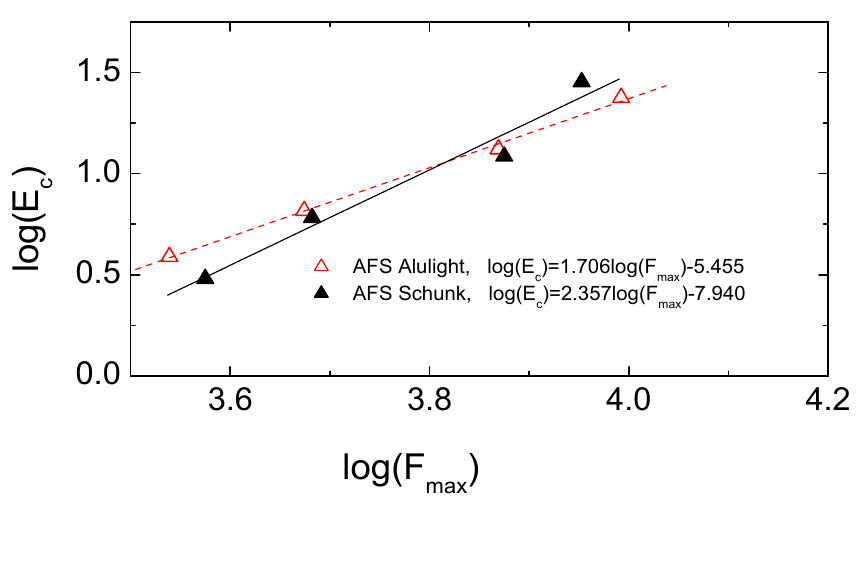
Figure 16. Contact energy dissipation vs. peak